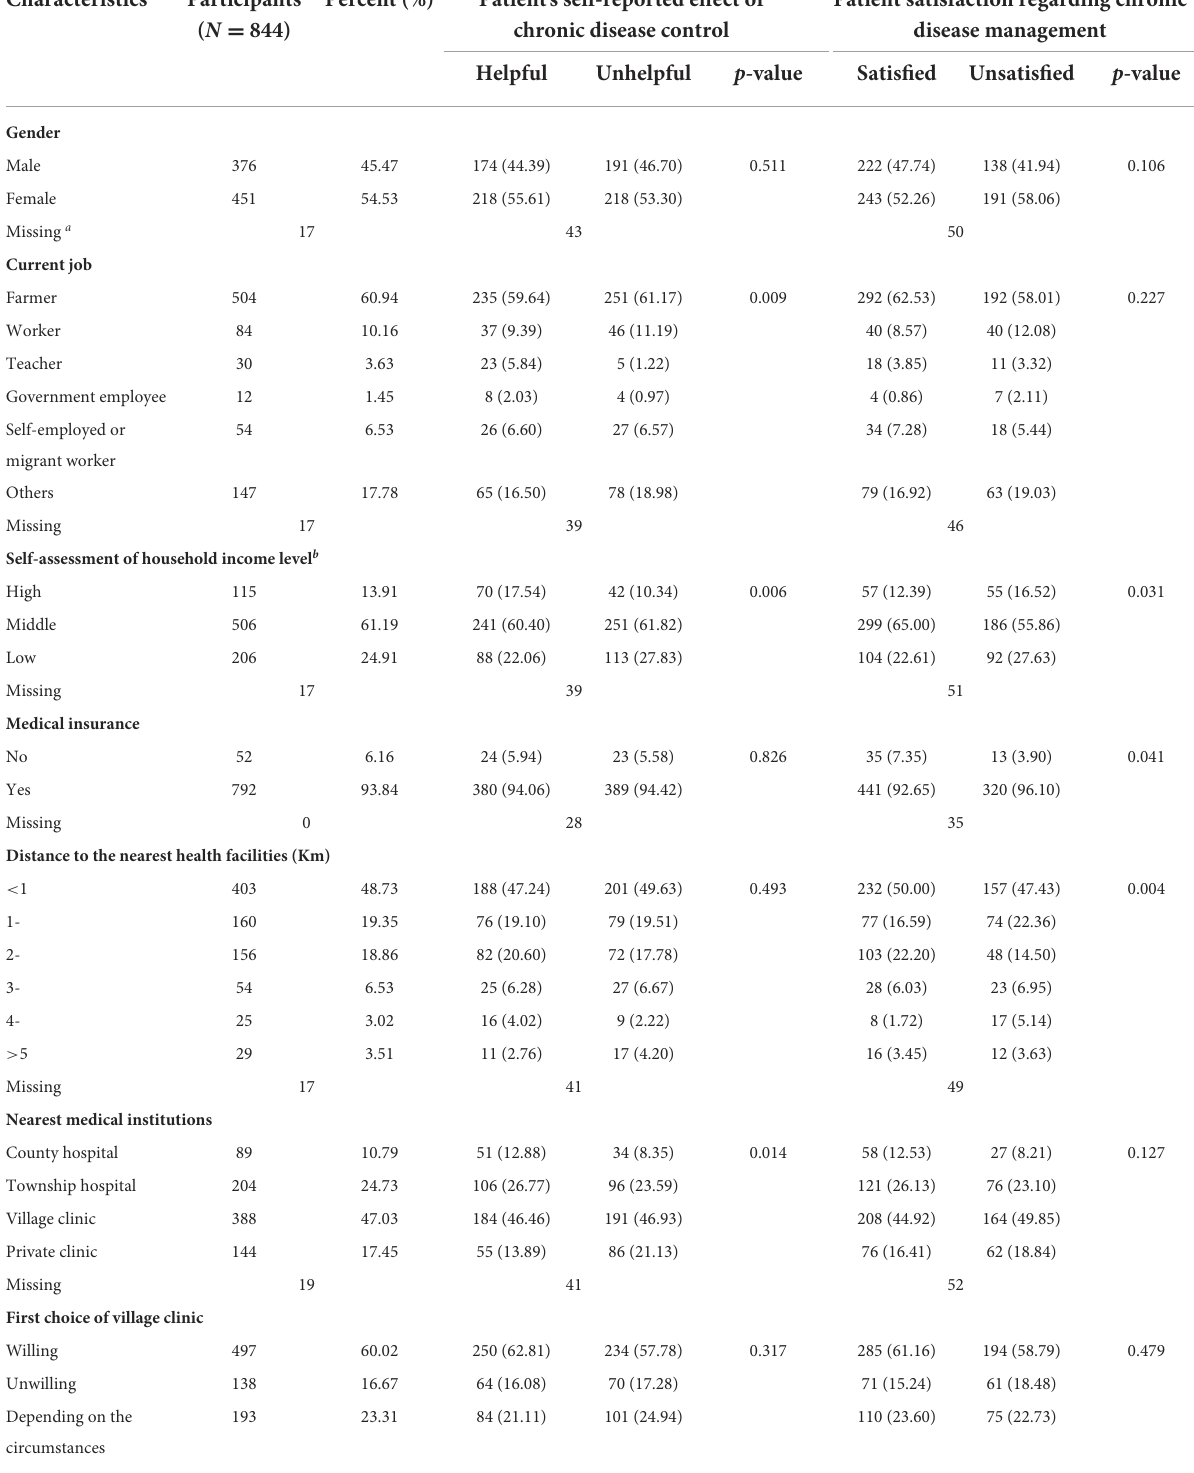
TABLE 2 The characteristics of participants, the comparison of patient satisfaction regarding chronic disease management, and the self-reported effect of chronic disease control in rural China.